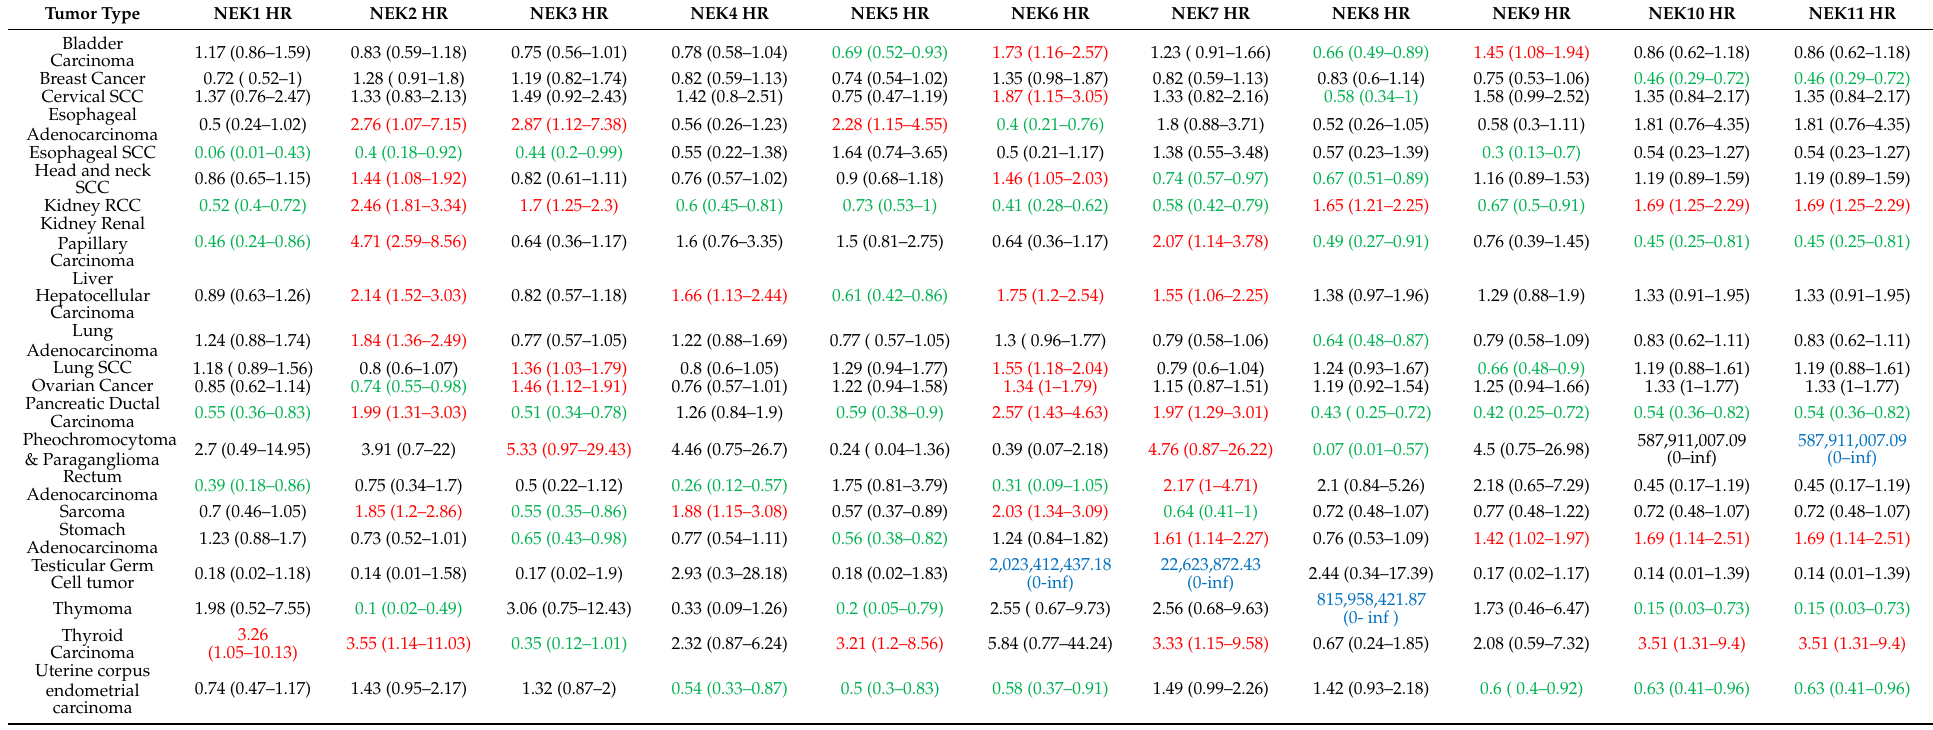
Table 1. Hazard ratios (HR) and associated confidence intervals (CI) comparing correlations between mRNA expression of NEK family kinases and patient survival outcomes for different cancers. Statistically significant ( p < 0.05) correlations are colored green for positive survival benefit and red for negative survival benefit, non-statistically significant correlations are colored black, and correlations with insufficient power (low n) are shown in